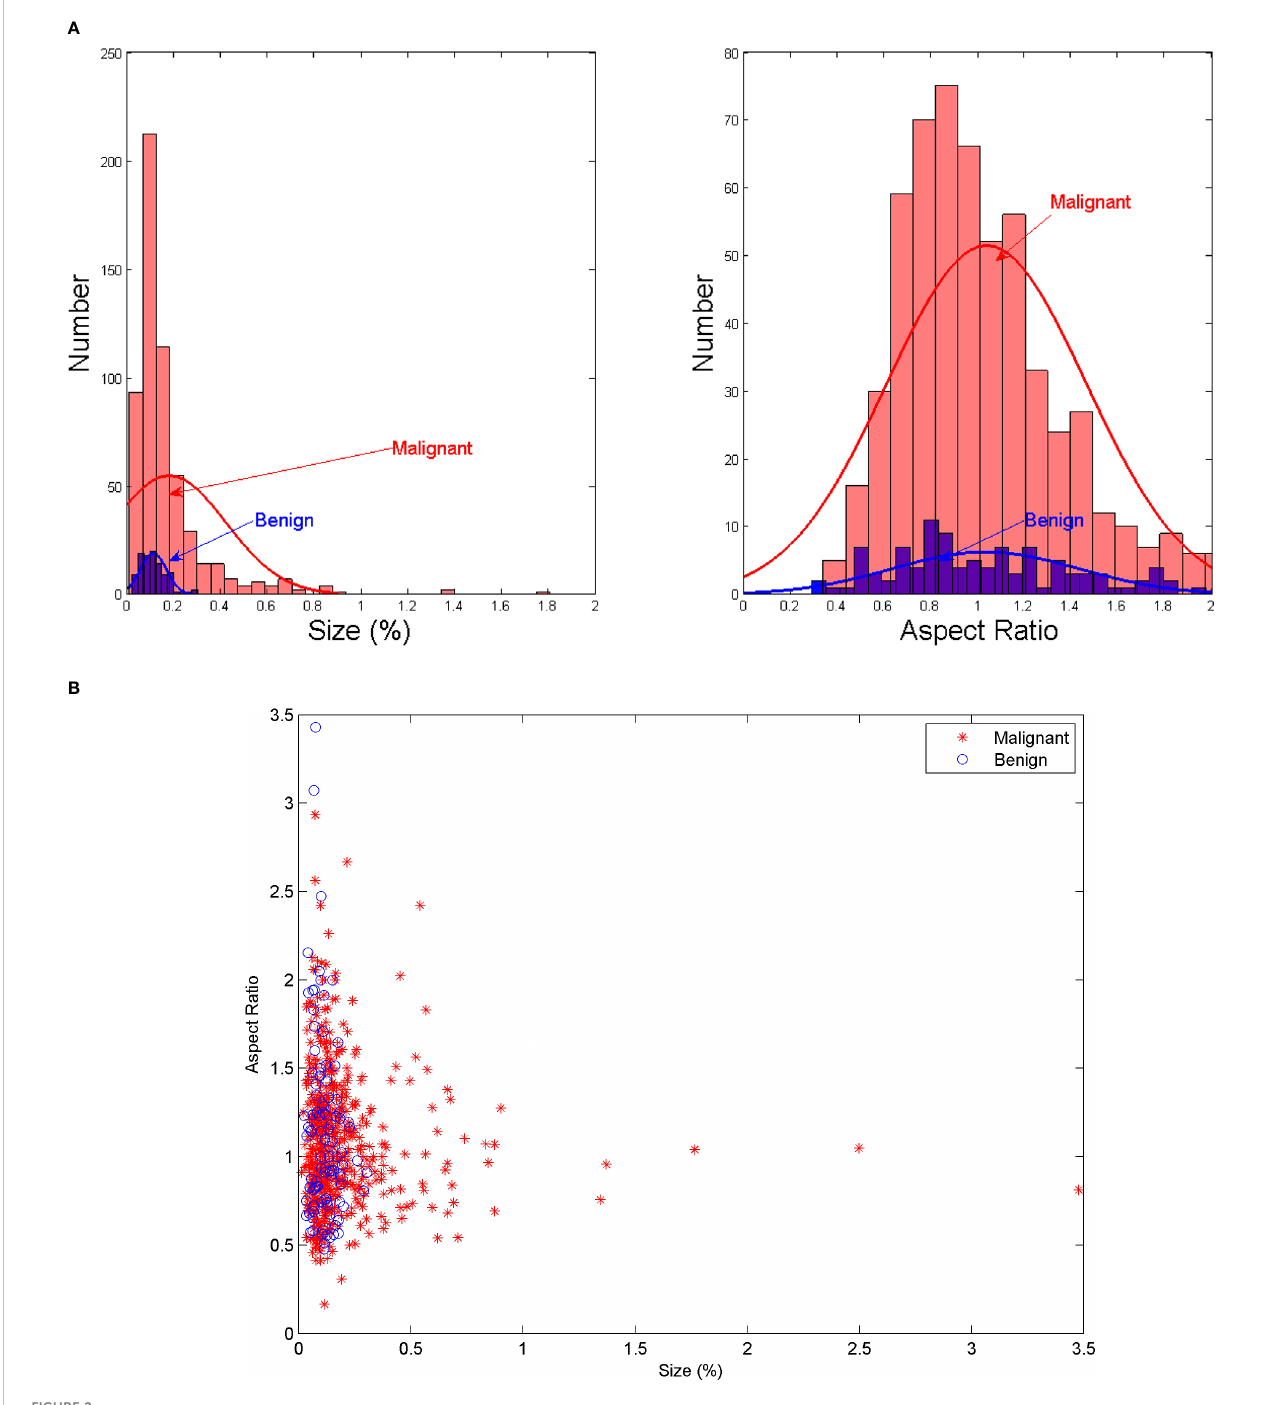
FIGURE 2 (A) The size and shape histograms of LNs (B) Joint distribution map of the size and shape of